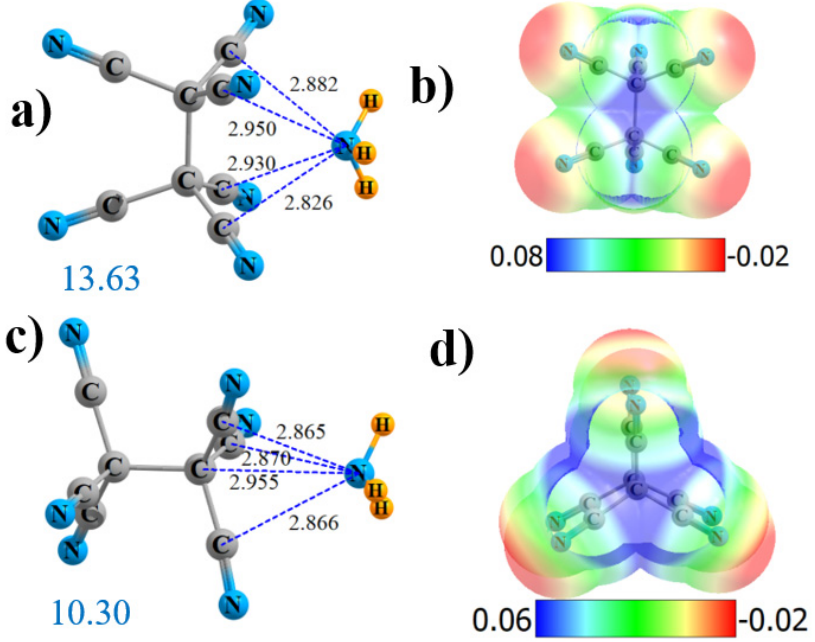
Figure 1. Geometries and monomer molecular electrostatic potential (MEP) of (CN) 3 C-C(CN) 3 interacting with NH 3 from the side ( a , b ) and end ( c , d ). Dotted lines denote AIM bond paths. Large blue numbers indicate interaction energy in kcal / mol. Distances in Å and MEP in au. MEP can be converted to kcal / mol by factor of